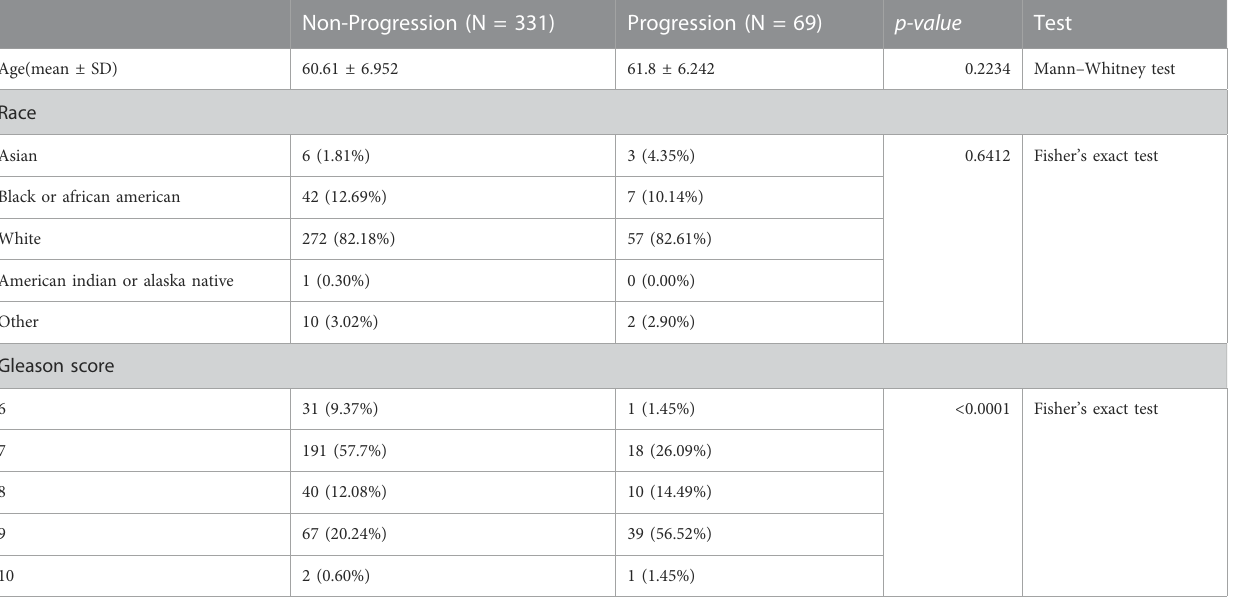
TABLE 1 Demographics, clinical characteristics and progression